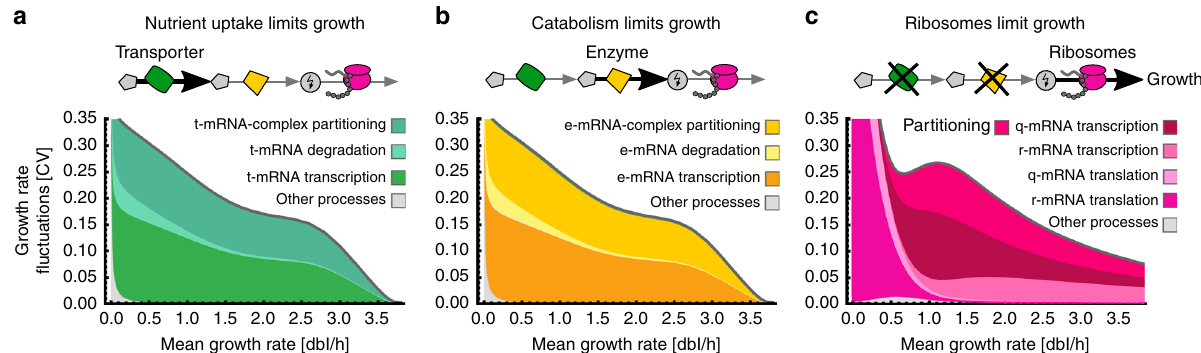
Fig. 3 Growth limitations determine the sources of growth fl uctuations. a Fluctuations in transcription of transporter mRNAs and their stochastic partitioning dominate growth variability when nutrient uptake is growth-limiting (import rate < enzymatic rate, see Supplementary Table 1). Other processes such as translation of proteins are largely negligible. b When catabolism limits growth (import rate > enzymatic rate), fl uctuations in enzymatic mRNAs instead explain most of the observed variation. We vary catabolic turnover rates v m relative to nutrient uptake rate v t . c In a reduced model with constant supply of resources, ribosome production limits growth. Growth variability results from transcription, translation and partitioning of